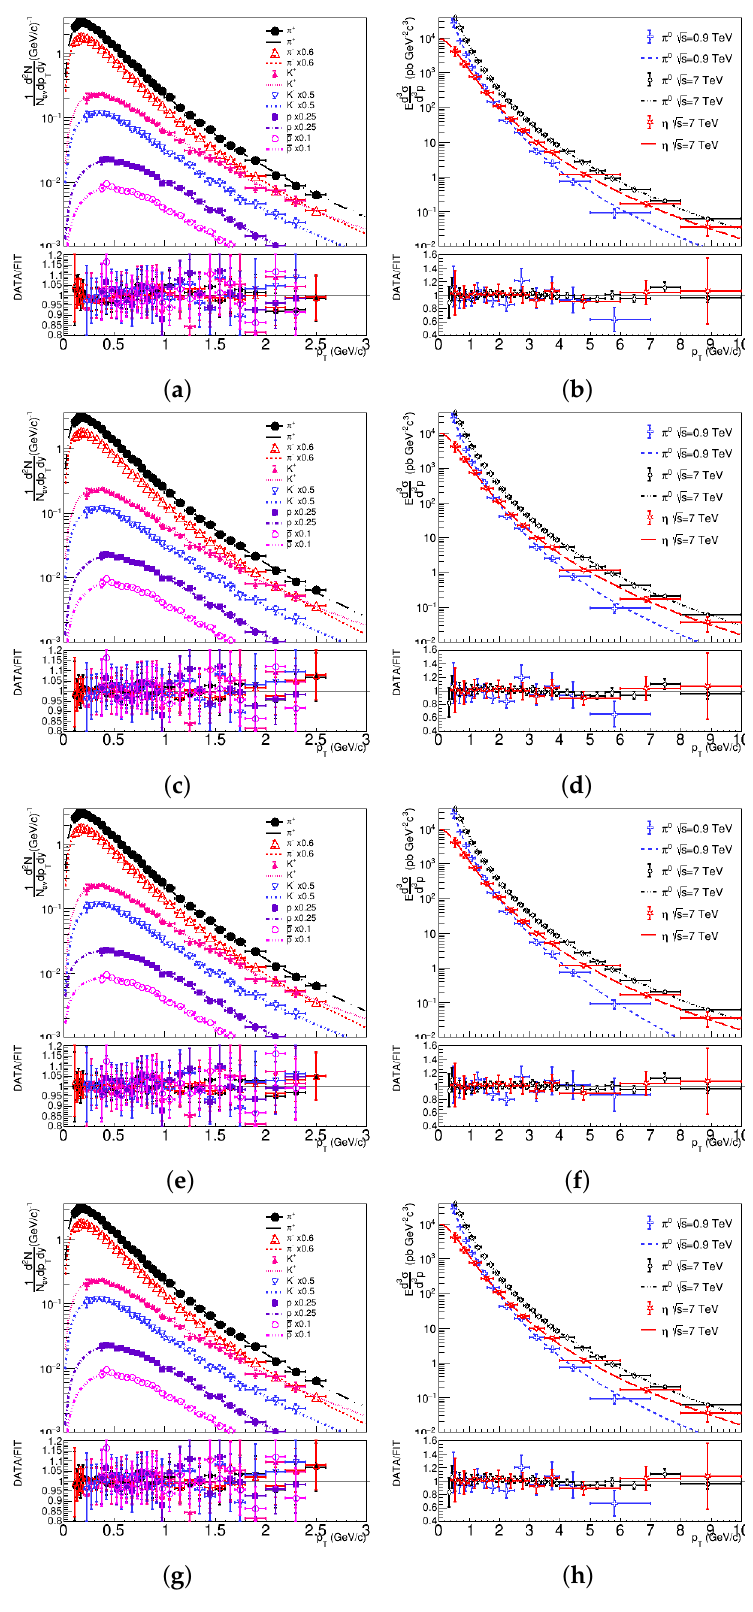
Figure 1. The double-differential transverse momentum distributions with the fits by ( a , b ) Equa- tion (1), ( c , d ) Equation (2), and ( e – h ) Equation (3), with the parameter a o left free ( e , f ) and a o = 1 ( g , h ). The data are from proton-proton collisons at the center-of-mass energies, taken from